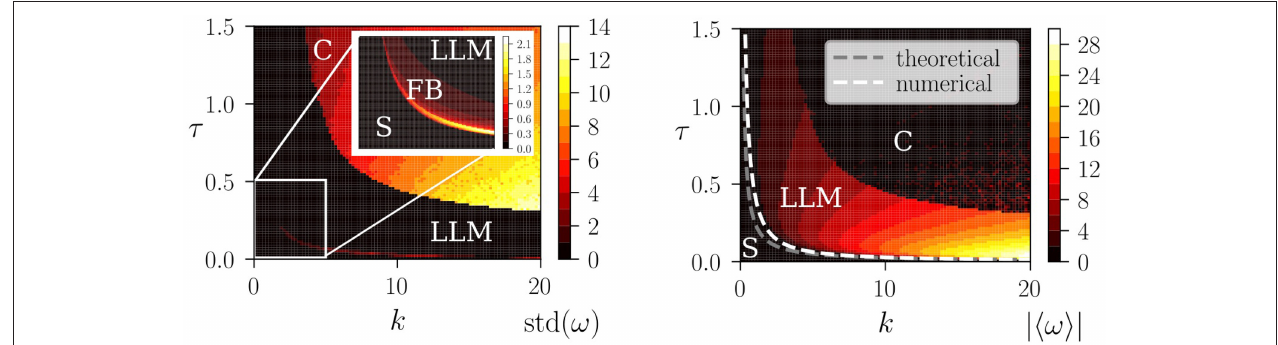
FIGURE 9 | Left : The numerical phase diagram, as obtained by simulating (13) for a = 4, I = 0.05 and f = 0.5. Shown is the standard deviation h ω 2 i − h ω i 2 of the angular frequency ω of the wheel (color coded), as averaged over time. Low values of std( ω ) correspond to vanishing or near constant std( ω ) = ω ( t ), as for the fixpoint solution (S) and for the limit-cycle locomotion (LLM). The transition to chaos (C) takes place through a crisis, with the route to locomotion p occurring, as discussed in section 4.2, via an intermediate phase of forth-and-back rolling (FB). The inset enlarges the region k ∈ [0,5] and τ ∈ [0,0.5]. Right : The average angular frequency |h ω i| (color coded). The dashed lines correspond to the instability lines of the fixpoint solution, as obtained numerically (white) and analytically (gray), where the theoretical result is k c τ c = 2 f / a . See Equation